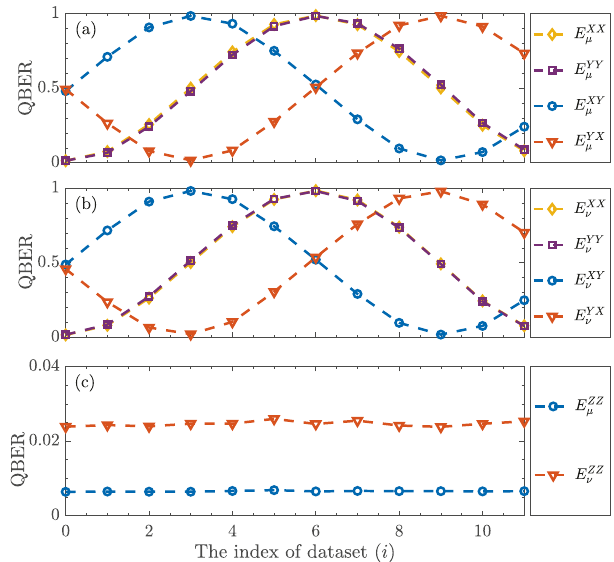
Fig. 5 The QBER of the merged datasets with the experimental measured data, here m = 12. The index of dataset i corresponds to P i . a shows the QBER of signal state on X , Y basis, b shows the QBER of decoy state on X , Y basis, c shows the QBER on Z basis. Each point represents the merged result of each dataset.